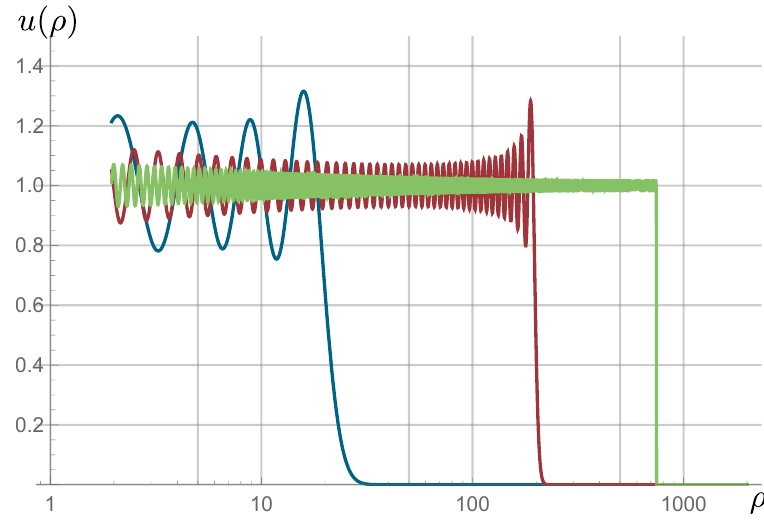
Figure 4 . The phase space density u as a function of ρ in (C.4). The blue solid, red solid, and green solid lines show the behavior of u in (C.3) when N = 10 , 100 , 1000 ,